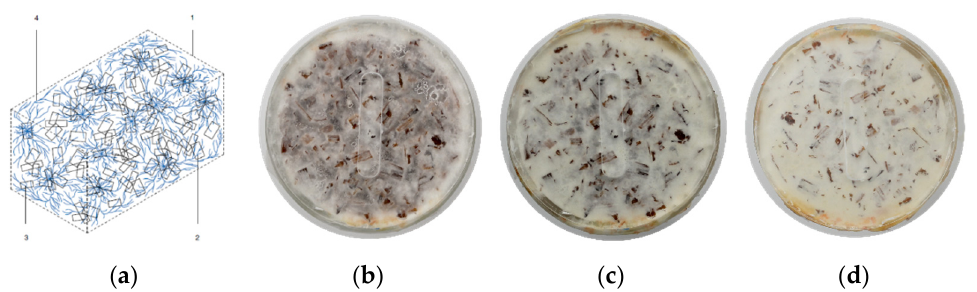
Figure 1. ( a ) The conceptual illustration describes the systematical formation of skeletal hyphae: the dashed line symbolizes the material interfaces (1); the rectangles, substrate consisting of coarse (2) and fine (3) wood chips; and the blue lines, the dense network of mycelial threads (4). The photos show the growth of mycelial cross-linked growth over time ( b ) after two weeks, ( c ) after three weeks, and ( d ) after four weeks.